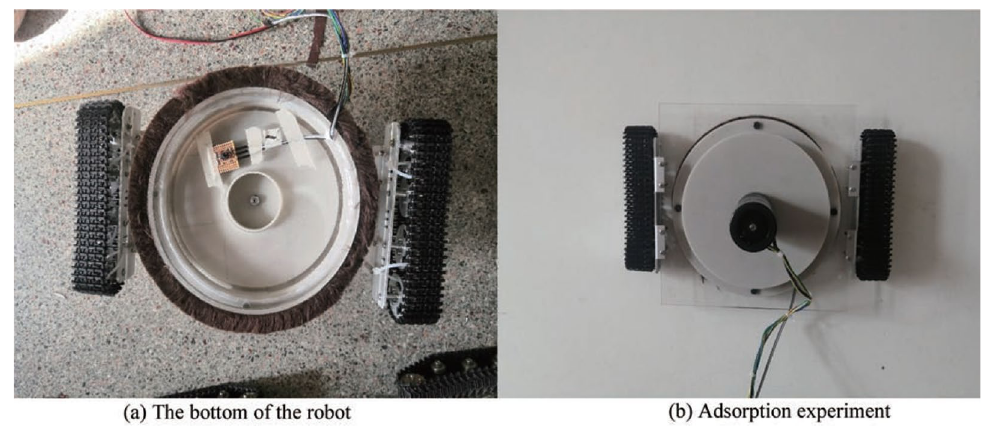
Figure 10. Circular negative pressure cavity and experiment.